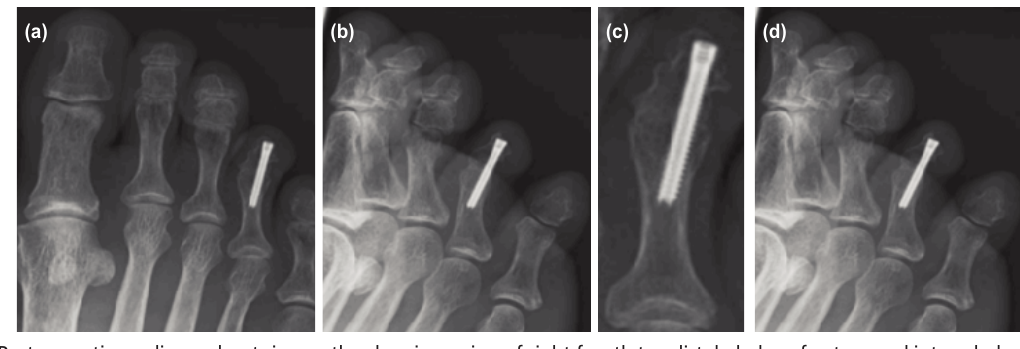
Post-operative radiographs at six months, showing union of right fourth toe distal phalanx fracture and inter-phalangeal fusion. Fig. 3: (a) Dorso-plantar foot view, (b) Oblique foot view, (c) Magnified dorso-plantar fourth toe view, (d) Magnified oblique fourth toe